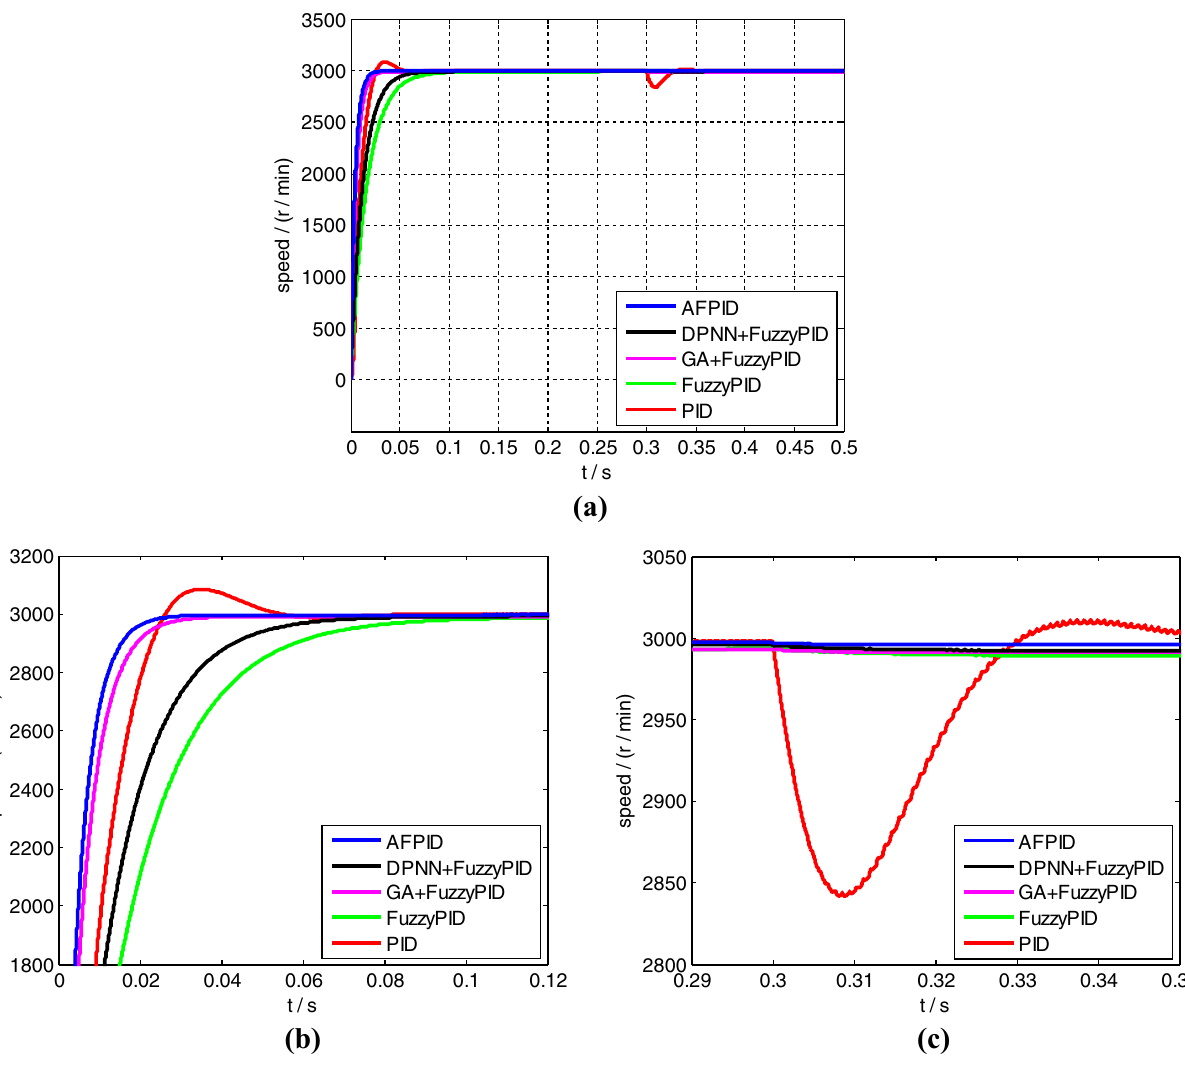
Fig. 8 The comparison of speed variation with fix load disturbance: a speed response curve of 0–0.5 s, b speed response curve of 0–0.12 s, c speed response curve of 0.29–0.35 s Table 5 The performance indexes under the condition of sinusoidal load disturbance